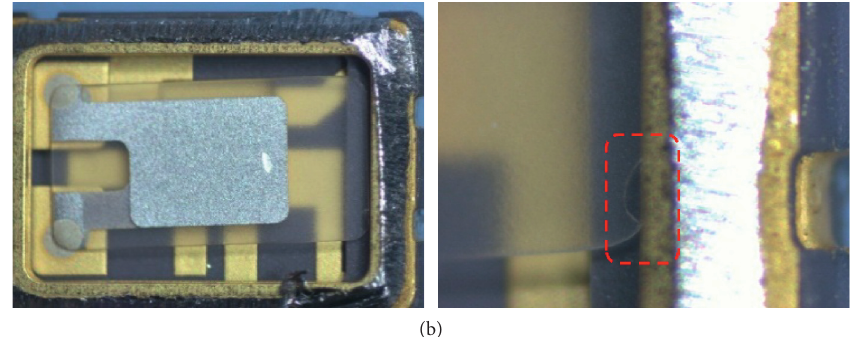
Figure 20: The fracture of the specimens after the experiment. (a) Specimen on C1 board. (b) Specimen on C2